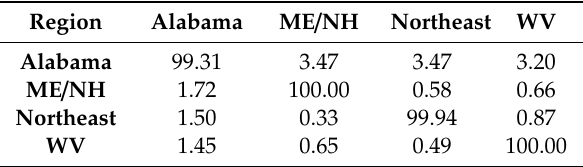
Table 3. Pairwise percent di ff erence values for COI for all specimens in this study, estimated by exporting a distance matrix of “% identity” between all samples, as implemented in Geneious R11. Values below the diagonal represent average pairwise percent di ff erences between regions, values along the diagonal represent average pairwise di ff erences within regions, and values above the diagonal represent the maximum pairwise percent di ff erence between individuals in each